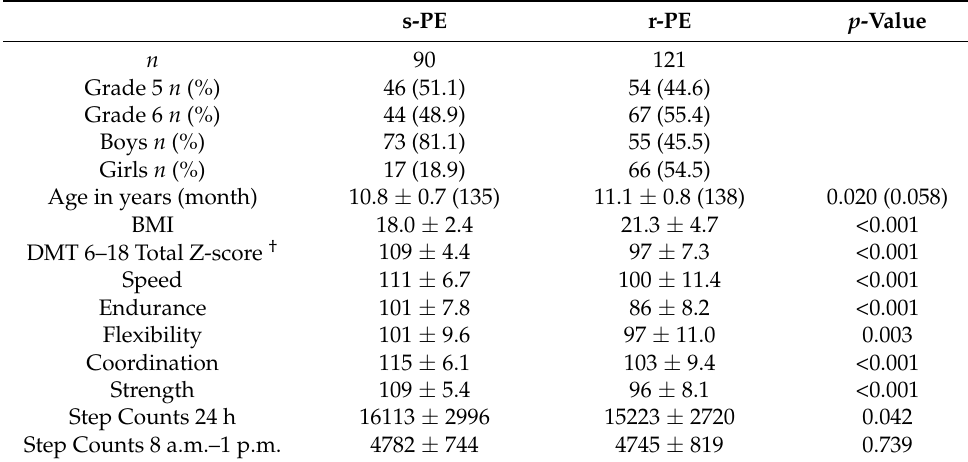
Table 1. Sample characteristics n =